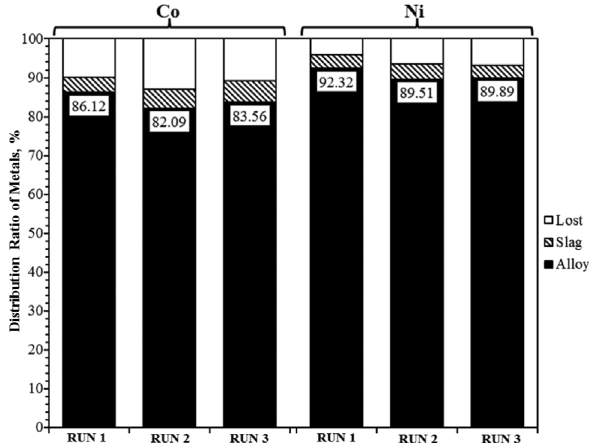
Fig. 4: The distribution ratios of Co and Ni among alloy, slag and scattered parts obtained by 20% Al 2 O 3 addition to batch type SHS reactions under normal gravity